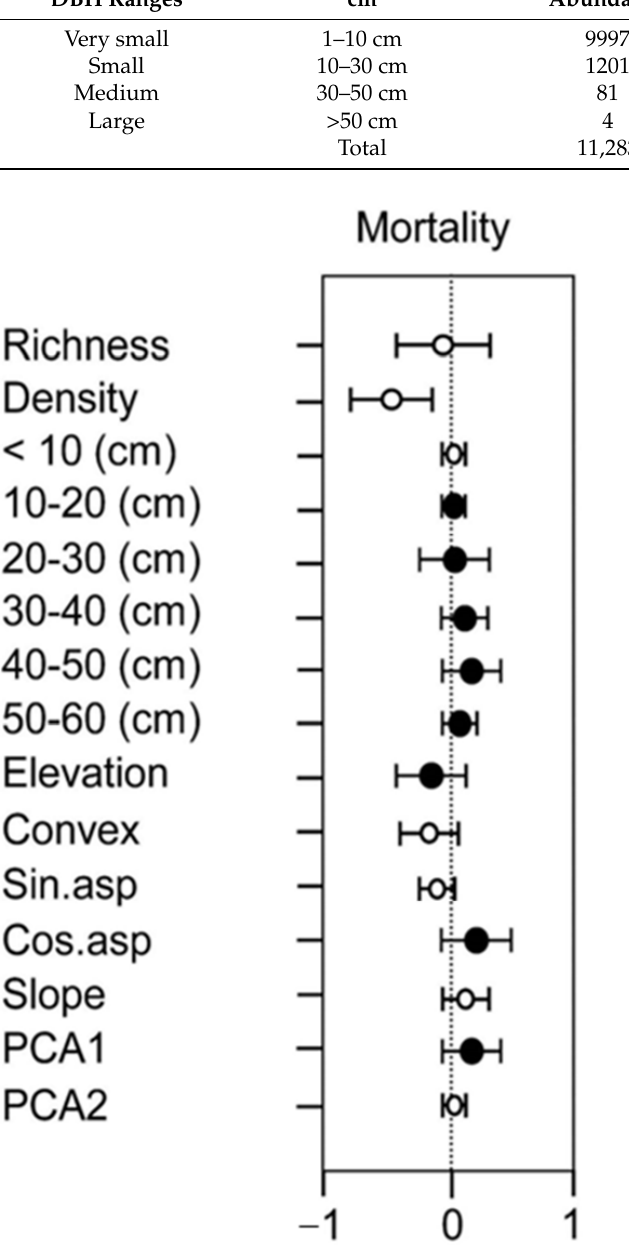
Figure 2. Drivers of tree survival in the 20 ha study